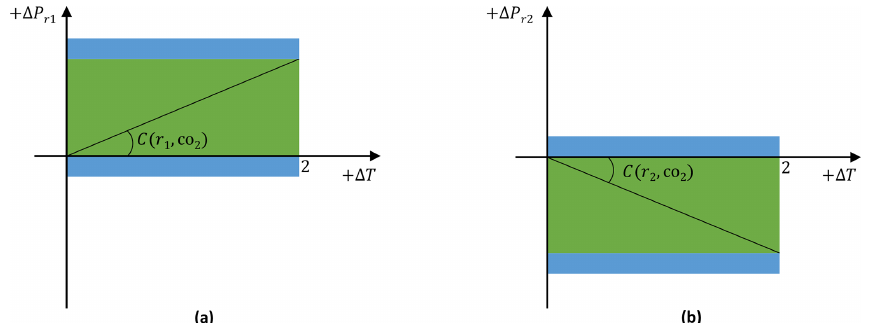
Figure 1. Schematic of precipitation guardrails for two hypothetical regions r 1 and r 2. r 1 is characterized by a positive CO 2 (greenhouse- gas-driven) scaling coefficient ( C ( r 1 , CO 2 ) > 0), and r 2 is characterized by a negative CO 2 scaling coefficient ( C ( r 2 , CO 2 ) < 0). The graphs show regional precipitation vs. global mean temperature, the latter in ◦ C. The green bands in panels (a) and (b) define the regular admis- sible area for precipitation change. The extra admissible areas (EA), as a fraction of regional standard deviation of natural variability, are demonstrated in